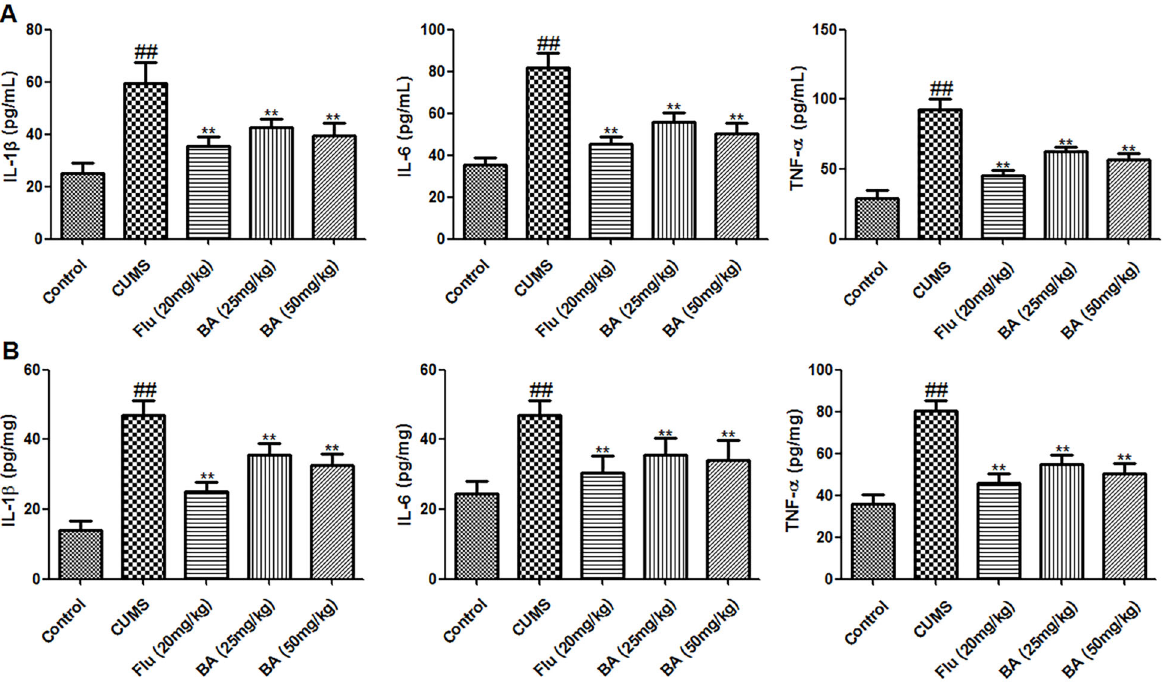
Figure 3. Effects of baicalin (BA) on proin fl ammatory cytokines in serum ( A ) and the hippocampus ( B ). Data are reported as means ± SE (n=8). ## P o 0.01 vs control; **P o 0.01 vs CUMS (chronic unpredictable mild stress) (ANOVA). Flu: fl uoxetine.